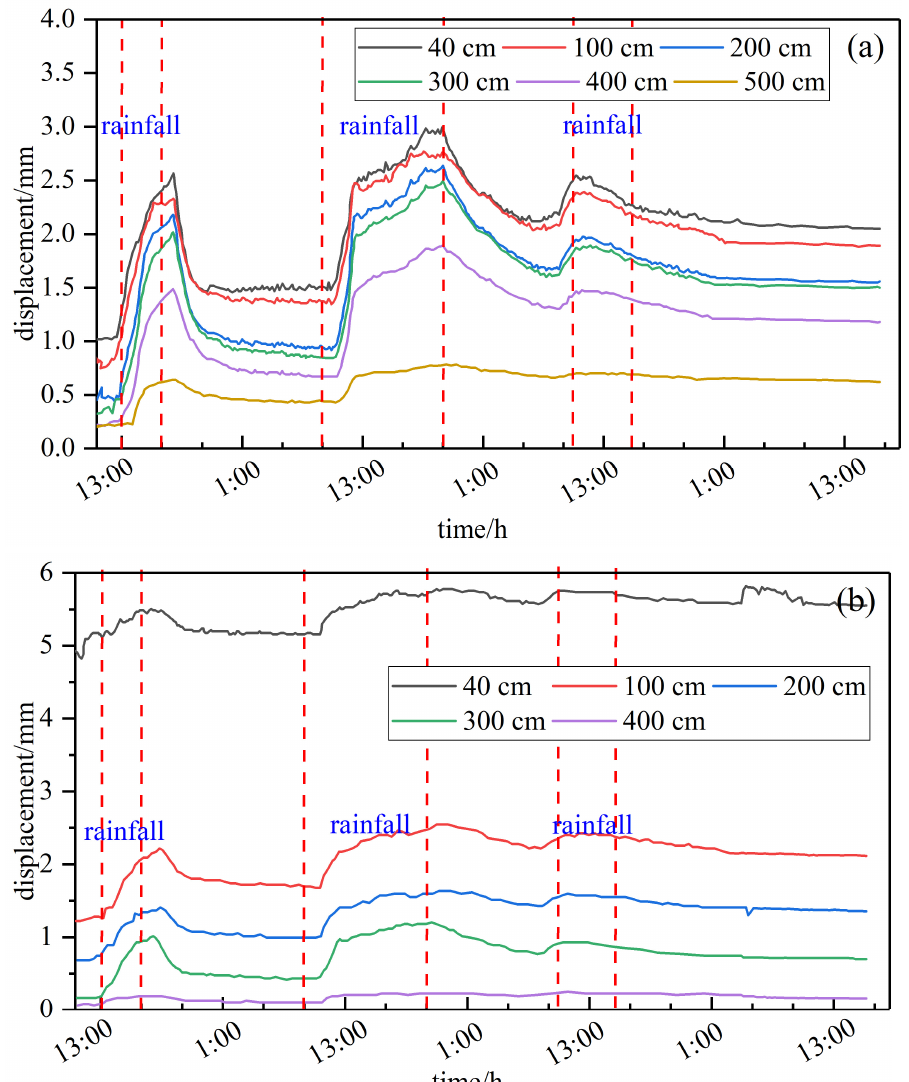
Figure 11. Displacement curves indifferent parts of the landslide under the second condition: ( a ) No. 1 borehole equipped with inclinometers, ( b ) No. 2 borehole equipped with inclinometers.